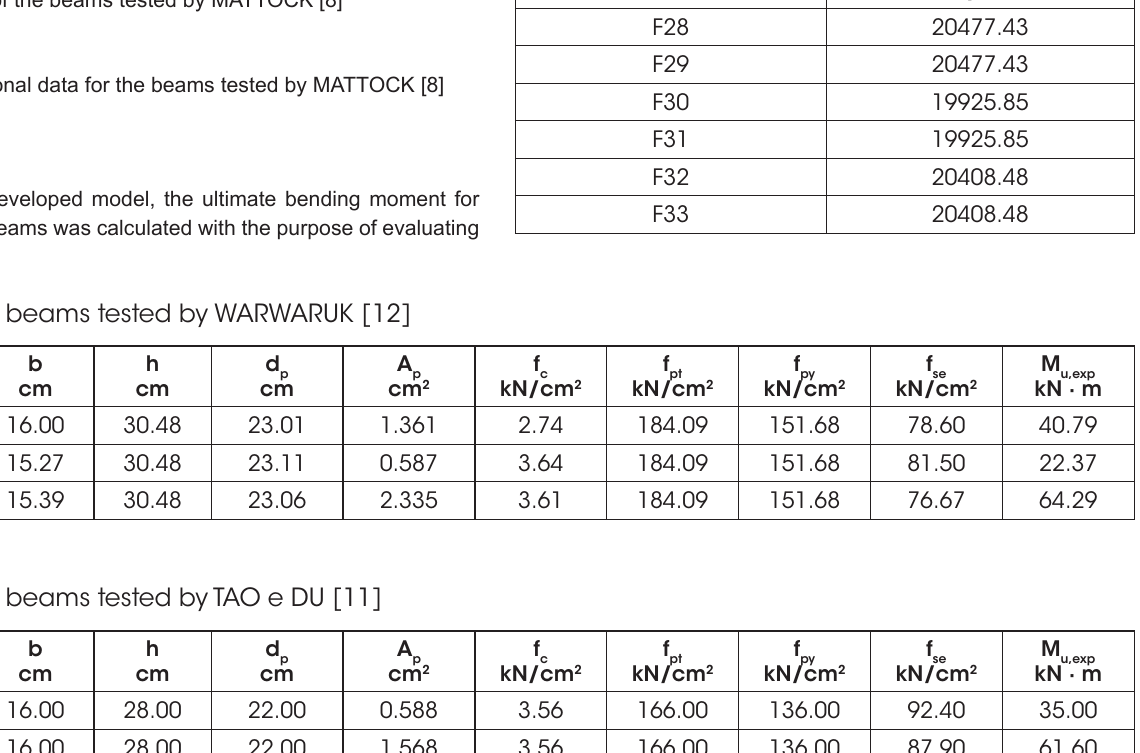
Table 7: Data of the beams tested by MATTOCK [8]